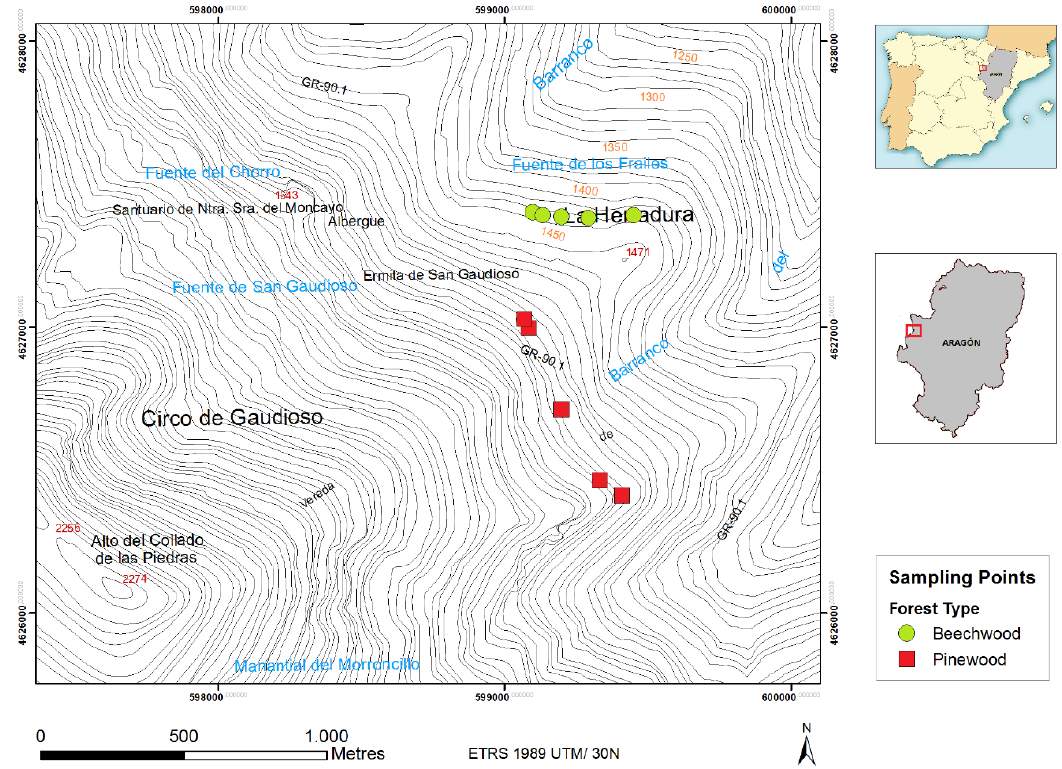
Figure 1. Location of the study area in Moncayo Natural Park (Zaragoza, north-eastern Spain). Round green signs refer to the beechwood sampling points and the red square symbols correspond to the pinewood sampling points.